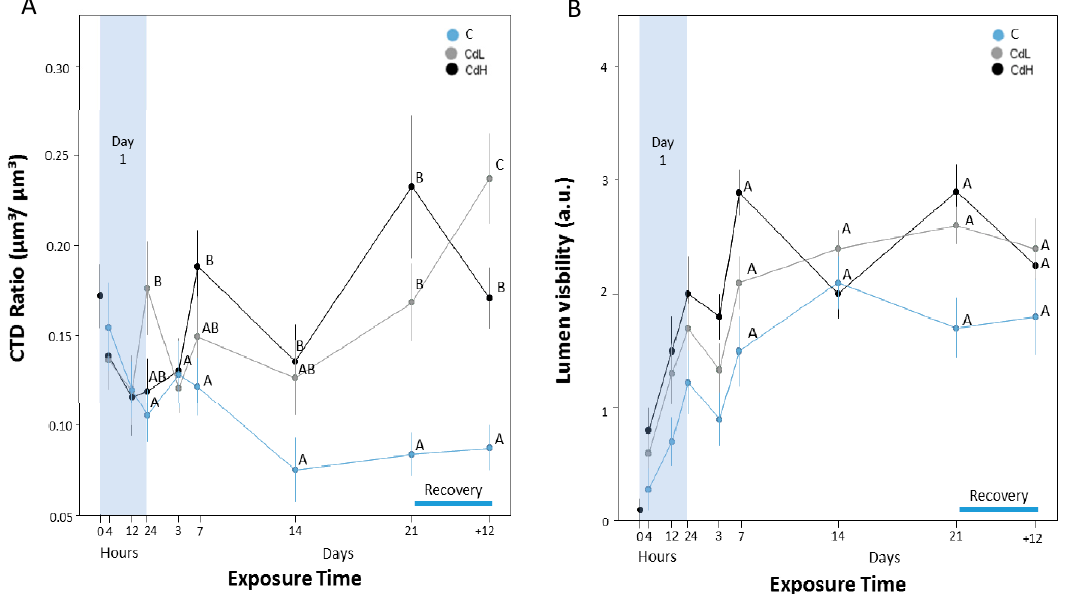
Figure 10. ( A ) Progression of structural integrity in the midgut gland/gonad complex of Littorina littorea , expressed by the connective tissue to digestive tubule ratio (CTDr). Means (symbols) and standard errors (bars) are shown. Different letter codes between single values of the same time point indicate statistically significant differences ( p < 0.05); ( B ) Progression of lumen visibility of midgut gland tubules, expressed in arbitrary units (a.u.) (see Table 1 in the Materials and Methods section for explanation). Means (symbols) and standard errors (bars) are shown. Different letter codes between single values of the same time point indicate statistically significant differences ( p < 0.05).